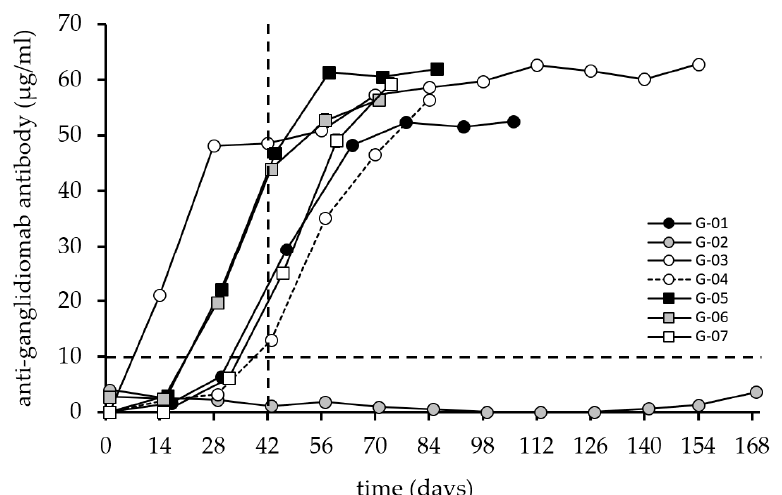
Figure 2. Induction of anti-ganglidiomab humoral response after vaccination with ganglidiomab over time. The anti-ganglidiomab serum levels were analyzed by ELISA following the procedure described in the materials and methods. Patients received 0.5 mL of 1 mg/mL of ganglidiomab adsorbed to